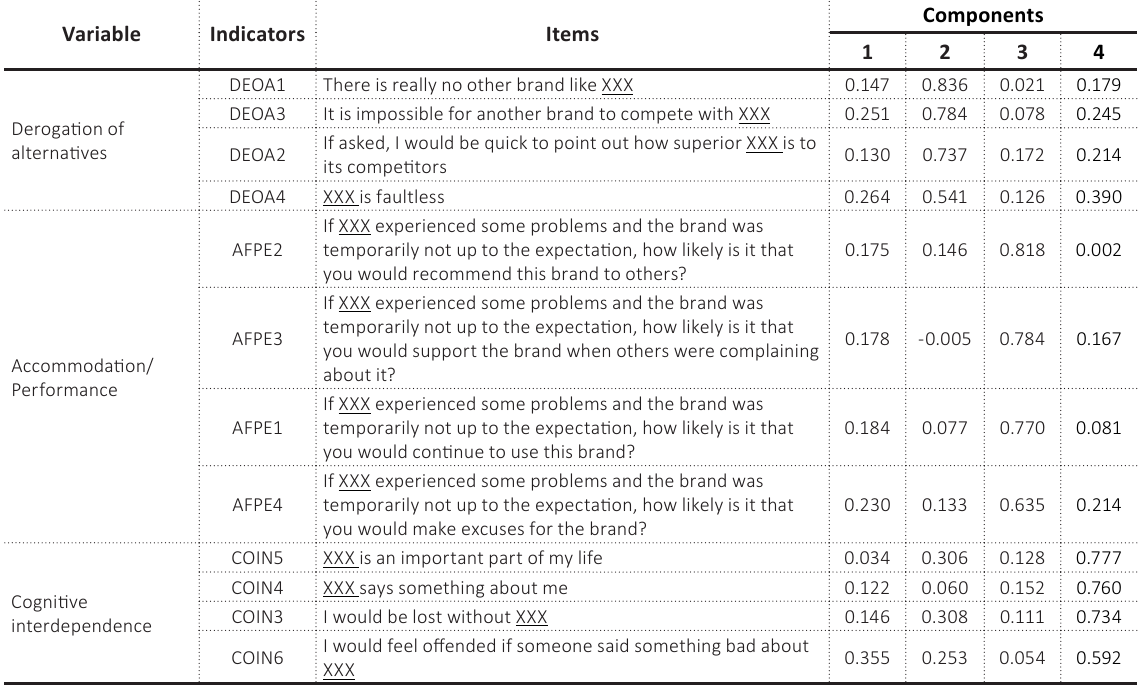
Table 3 (cont.). Exploratory factor analysis